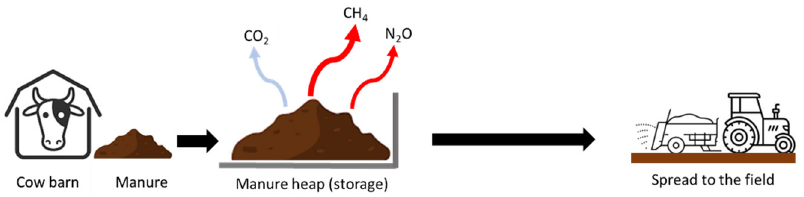
Figure 1. Scheme of Scenario